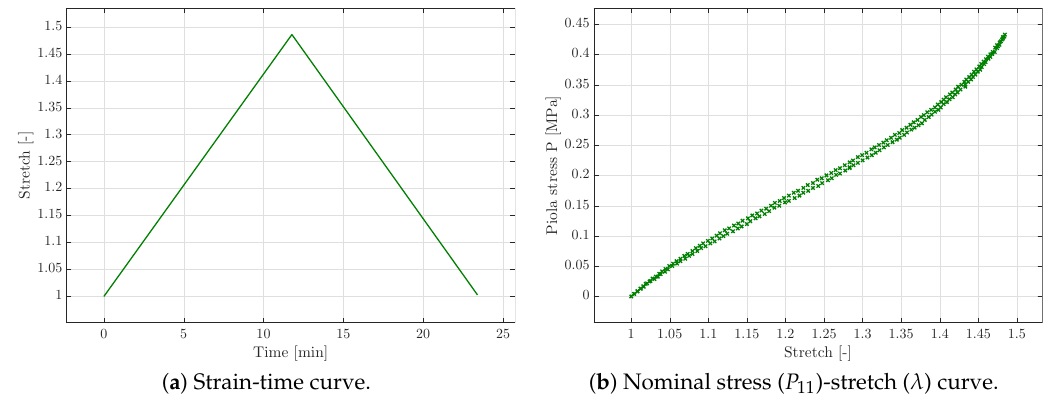
Figure 2. Tensile test results of the micro-testing machine, where the strain-rate is applied ( a ) in order to get the nominal stress ( b ).